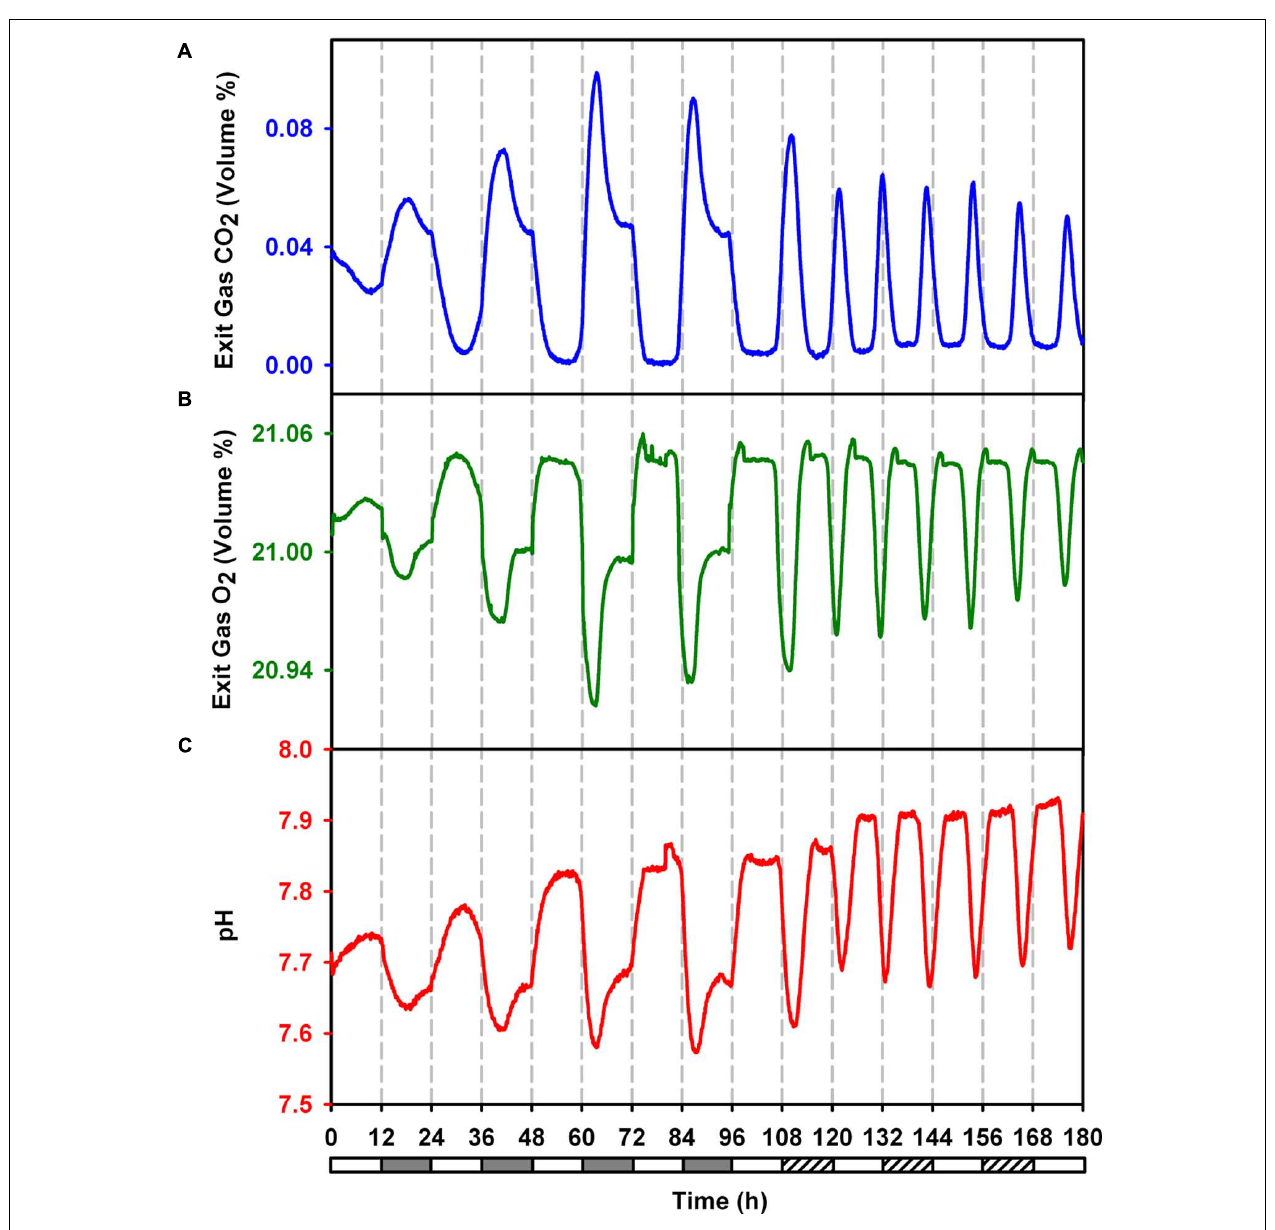
FIGURE 2 | Online monitored exit gas and growth medium pH profiles during 4 days LD followed by 3 days in LL to demonstrate sustained ocillations in metabolism during free run under constant light. (A) Concentration of CO 2 in exit gas. (B) Concentration of O 2 in exit gas. (C) pH of growth